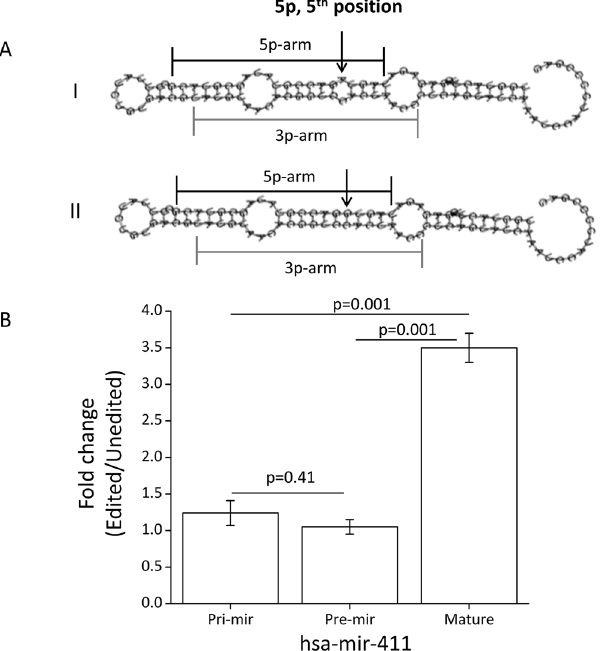
Figure 8. Increased expression of mature edited form of hsa-miR-411. ( A ) The figure shows the predicted secondary structures for the unedited (I) and edited (II) versions of pre-mir-411 using RNAfold Webserver. The arrow shows the position of editing found experimentally in mature miR-411–5p. The edited version (A changed to G) was predicted to have a more stable structure ( ΔΔ G = − 6.6 kcal/mol). ( B ) qRT-PCR data shows altered expression upon editing. A significant (two-tailed t-test, p = 0.001) increase in expression (3.5 fold, average of three replicates) was observed only for the mature form of miR-411. No significant (two-tailed t-test, p = 0.41) change was observed at the level of pri- and